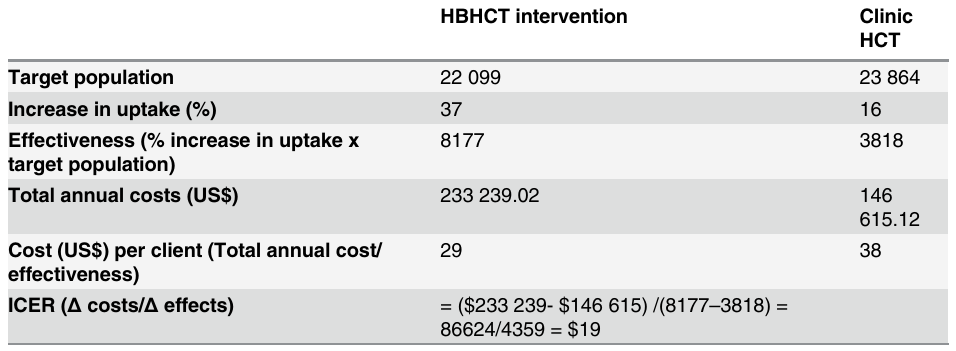
Table 4. Average costs, outputs and incremental cost-effectiveness ratio